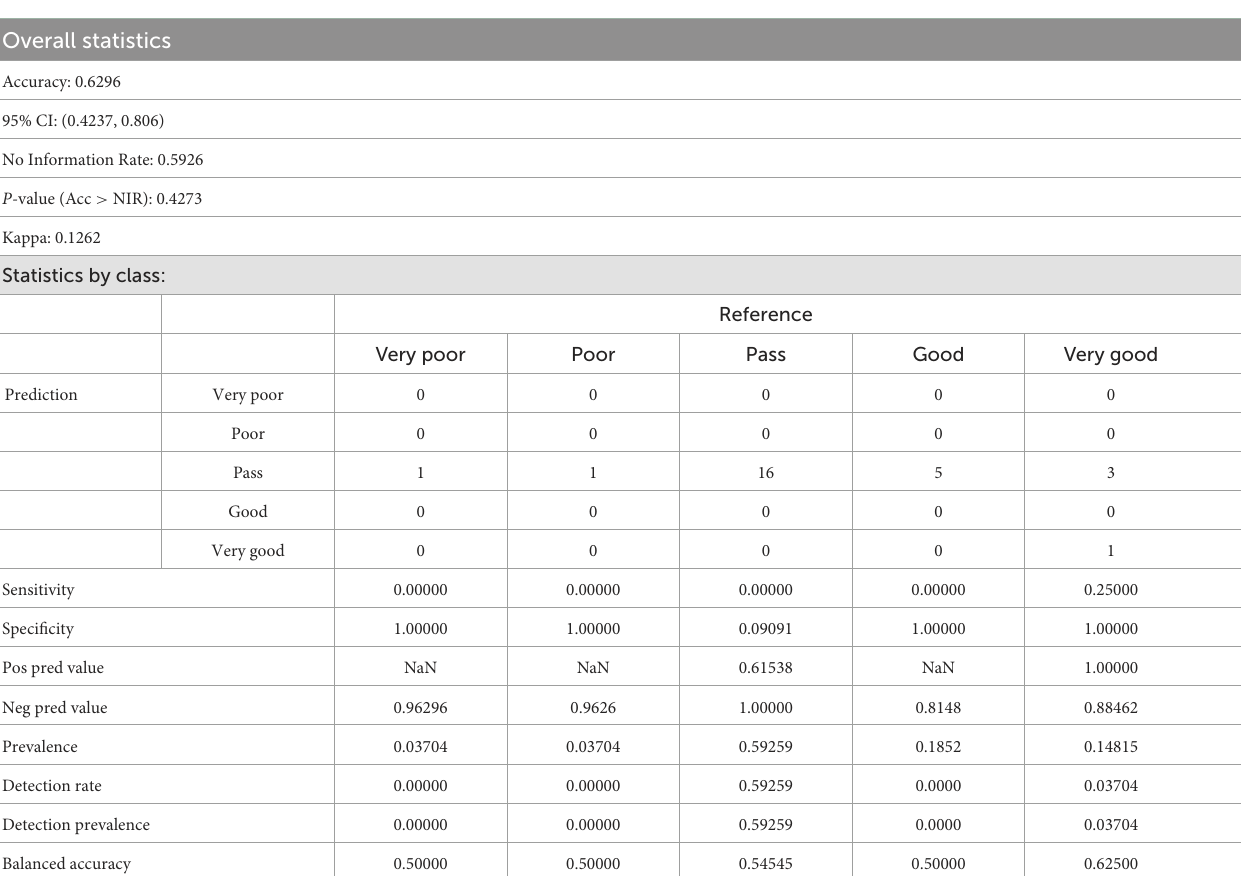
TABLE 4 Results of confusion matrix of the best SVM